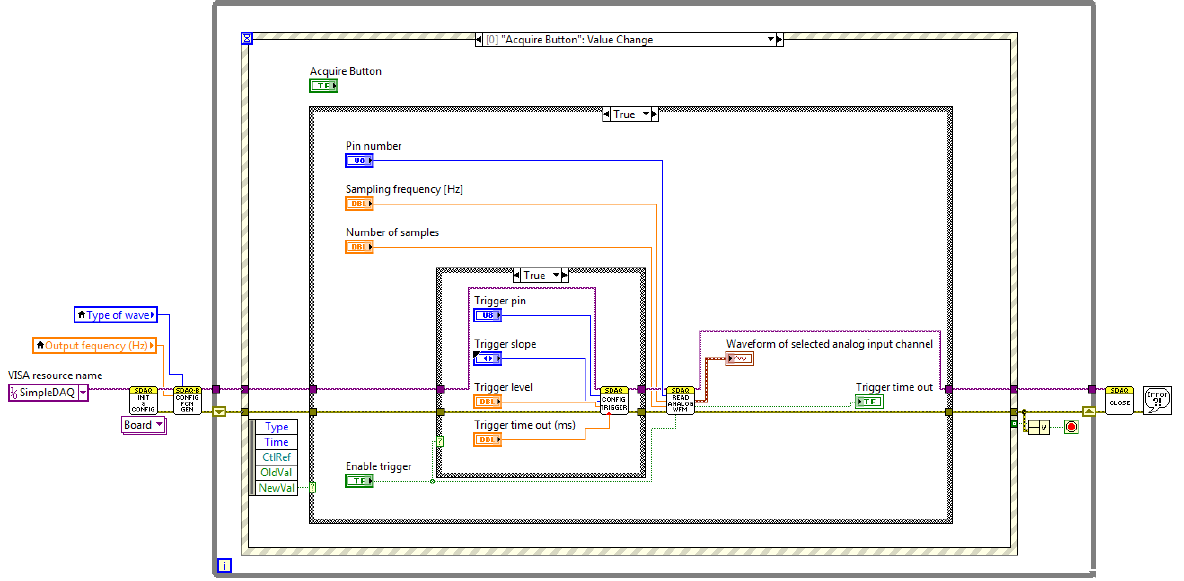
Figure 15. Application block